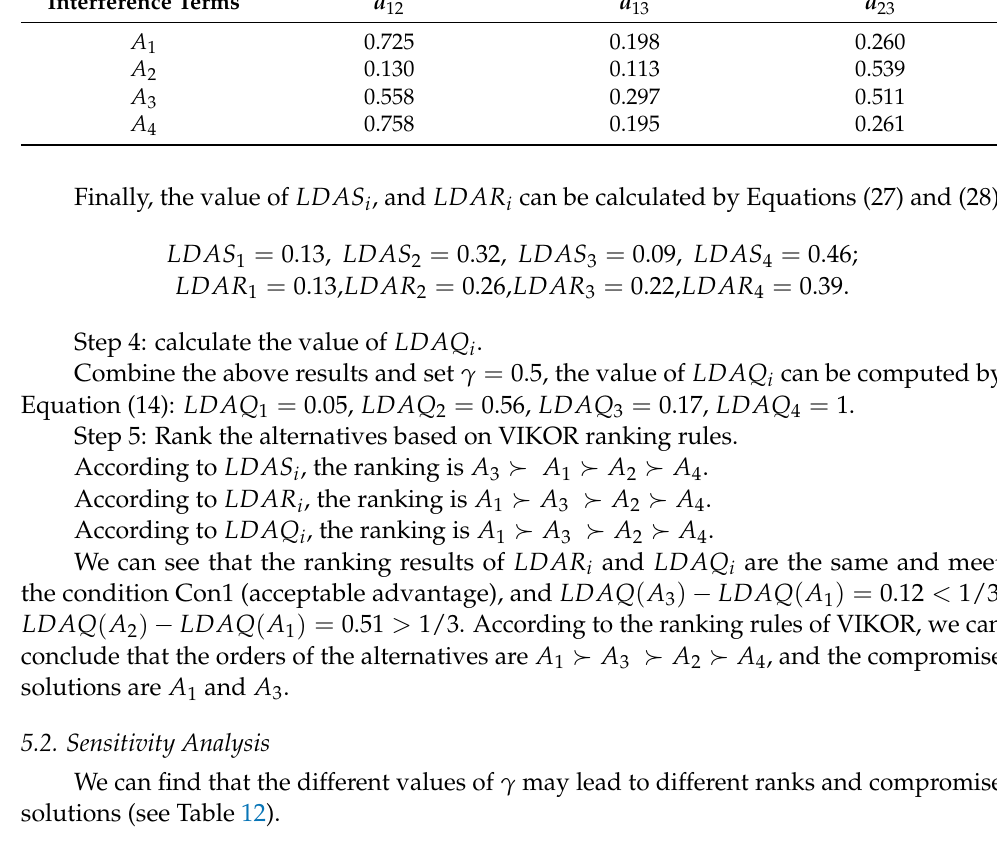
Table 12. Ranks and compromise solution with different v